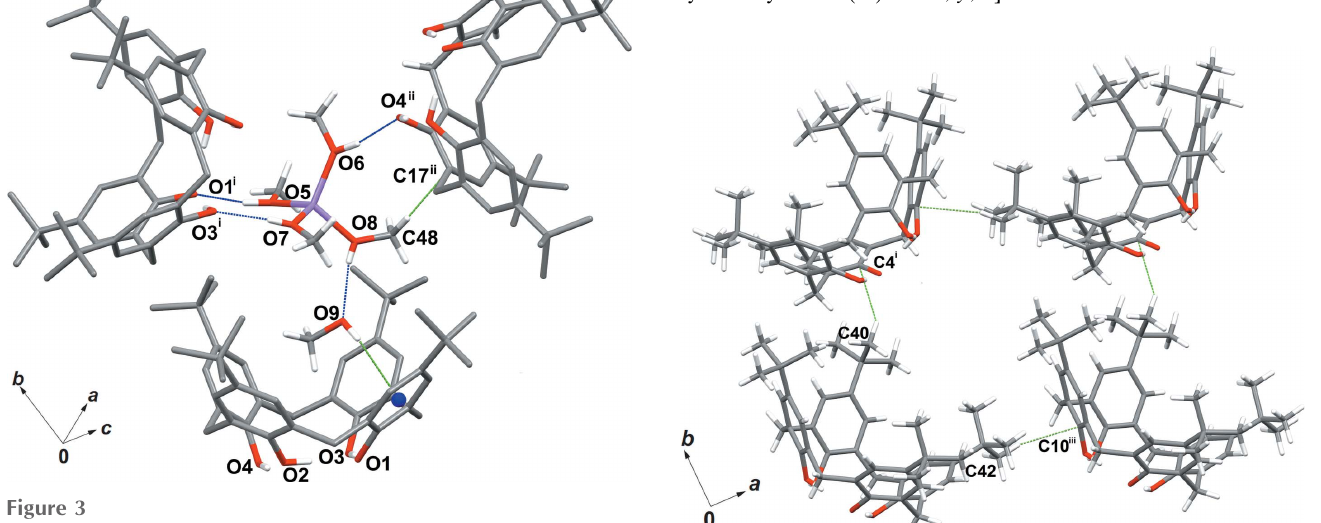
Figure 4 (cid:3) x , 1 (cid:3) z ; (ii) 1 (cid:3) y , + y , 3 + x , 1 C—H (cid:2)(cid:2)(cid:2) (cid:2) interactions involving four adjacent calix[4]arene anions in the 2 2 2 2 2 crystal structure. [Symmetry codes: (i) 3